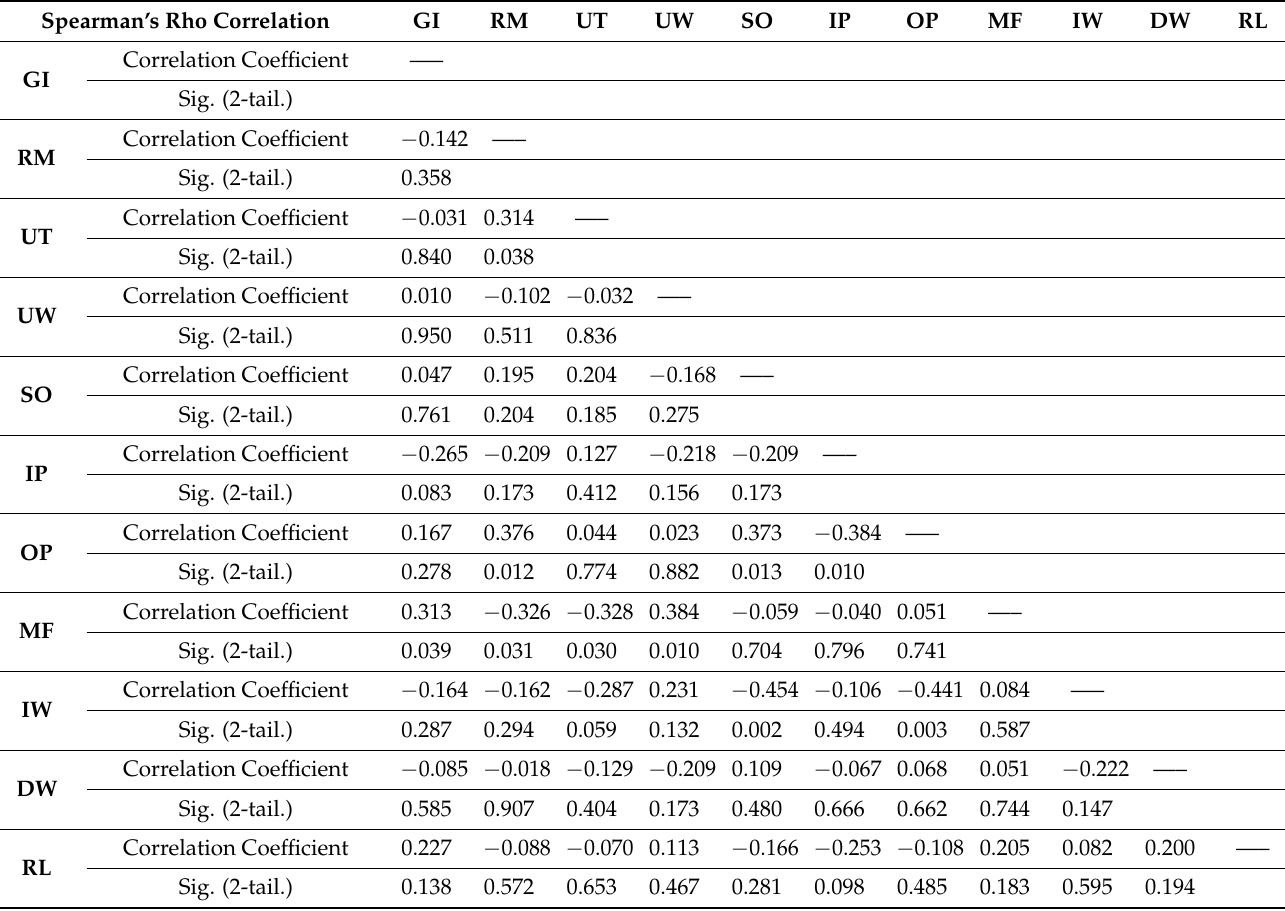
Table A1. Spearman’s ranks for correlations between various aspects of operational